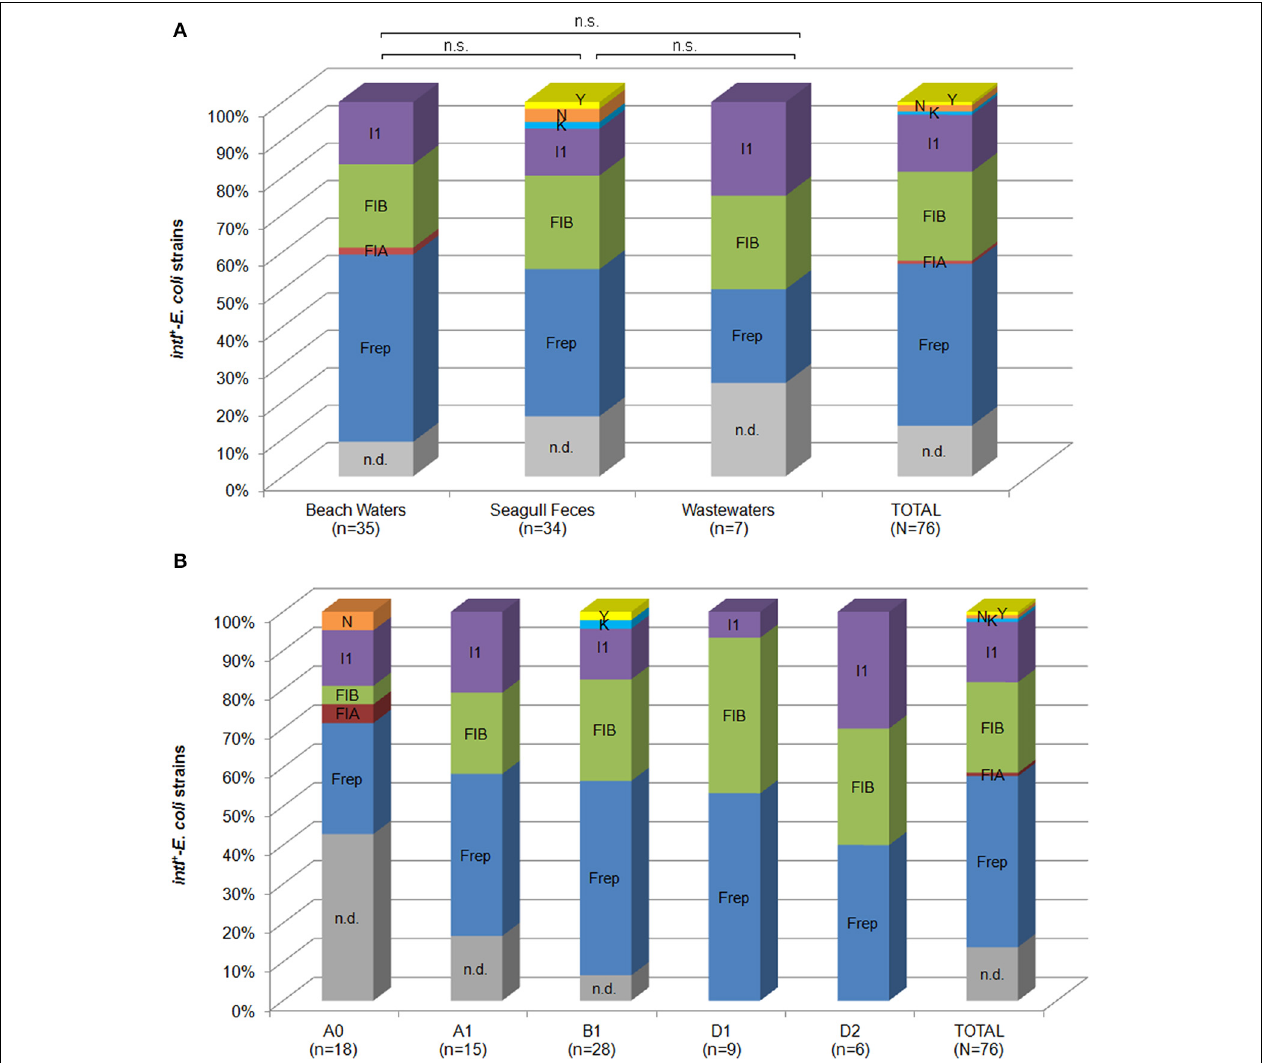
FIGURE 3 | Prevalence of replicon types detected in intI + -E. coli among different sources (A) and phylogroups (B). Abbreviations: n.d., not detected; n.s., not statistically